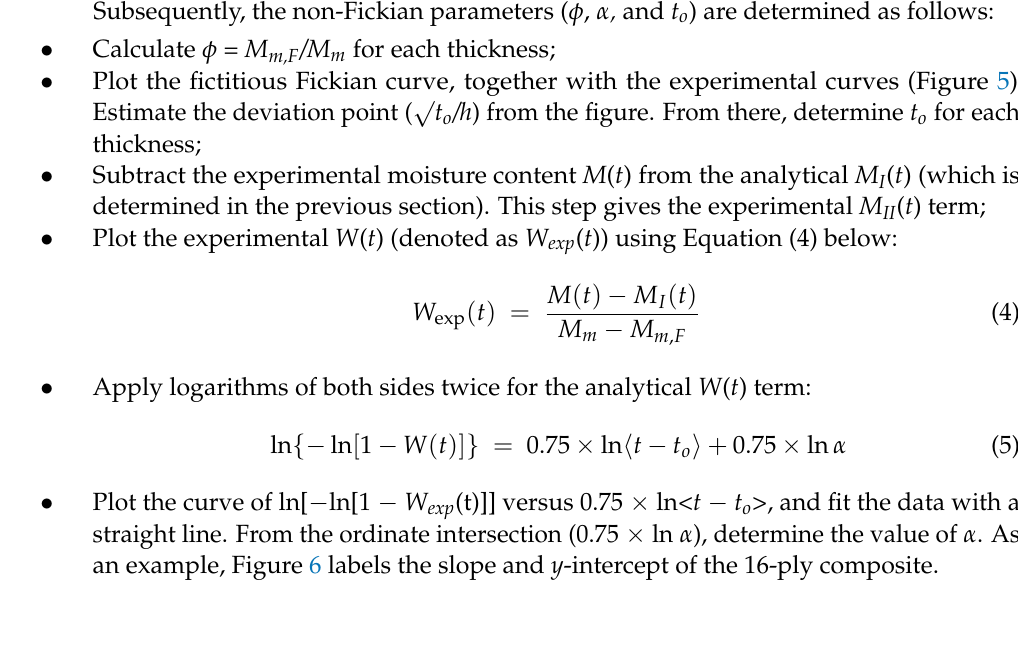
Figure 4. Determination of the slope of the initial linear region for specimens at all thicknesses. Table 1. Fictitious Fickian parameters of AS4/8552 carbon/epoxy composites.